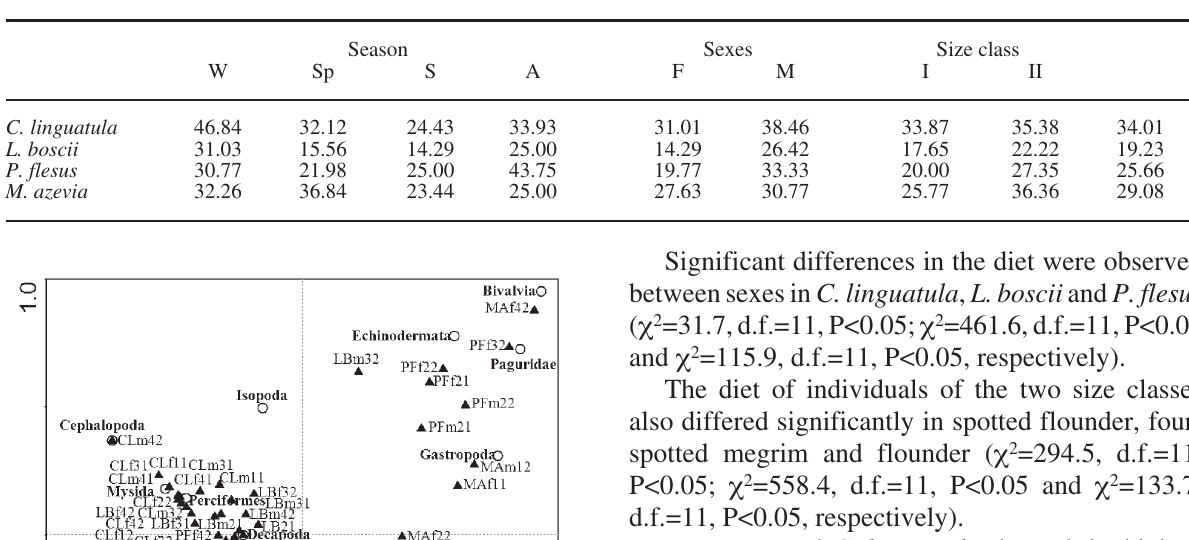
Table 2. – Vacuity index (VI) for each season (W, winter; Sp, spring; S, summer; A, autumn), sex (F, females; M, males) and size class (I, size class I; II, size class II) for C. linguatula , L. boscii , P. flesus and M. azevia .